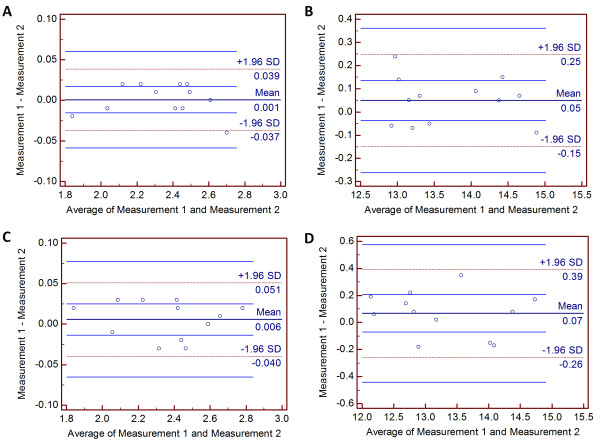
Bland-Altman plots showing intra-observer agreement on measurements of anterior chamber depth (ACD) and anterior chamber width (ACW). (A) Repeated ACD measurements made by observer 1. (B) Repeated ACW measurements made by observer 1. (C) Repeated ACD measurements made by observer 2. (D) Repeated ACW measurements made by observer 2. The horizontal lines represent the mean and 95% limit of agreement (LoA).